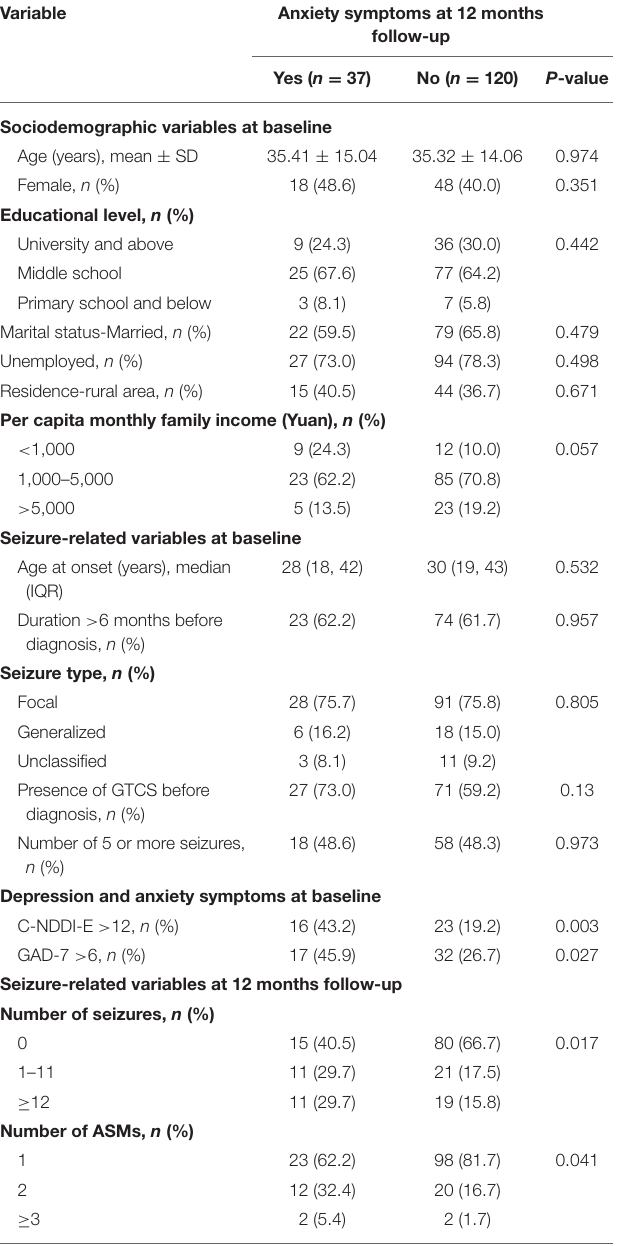
TABLE 4 | Multiple logistic regression for predictors of anxiety symptoms at the end of the 12-month follow-up period.